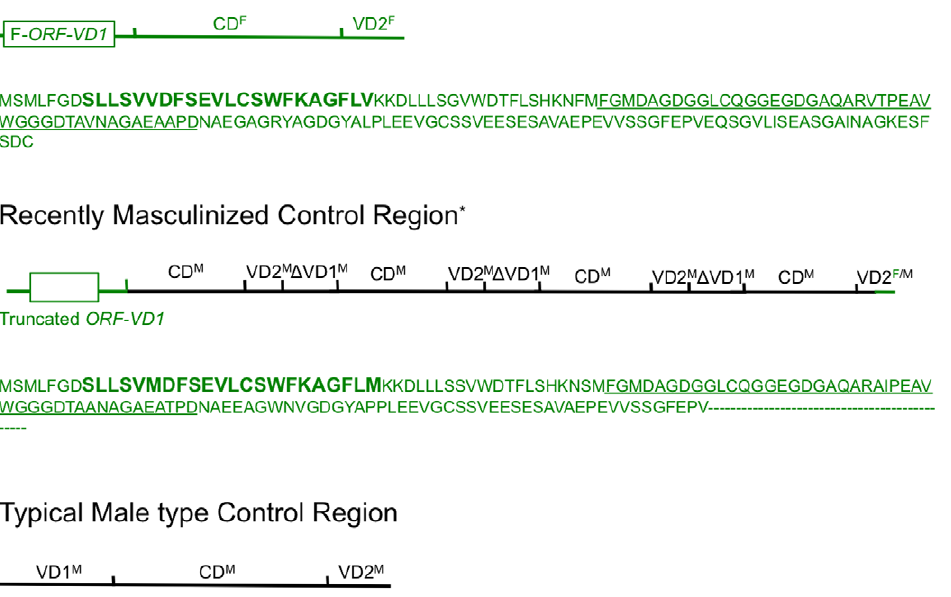
Figure 5. Schematics of the structure of a typical F-type (above), recently-masculinized (center, according to Venetis et al. [ 47 ] ) and typical M-type (below) control regions. The F- ORF-VD1 is identified in the F-type control region. The amino acids that constitute the putative transmembrane helix are indicated in boldface type and bigger characters. The stretch of , 60 residues showing the greatest similarity among the species is underlined. Dashes (–) denote the missing amino acid residues in the truncated F- ORF-VD1 . CD, conserved domain; VD1, variable domain 1; VD2, variable domain 2 [39,40]. *The ‘‘standard’’ F-type CR of M. trossulus , which is a F/M recombinant CR, is not presented.